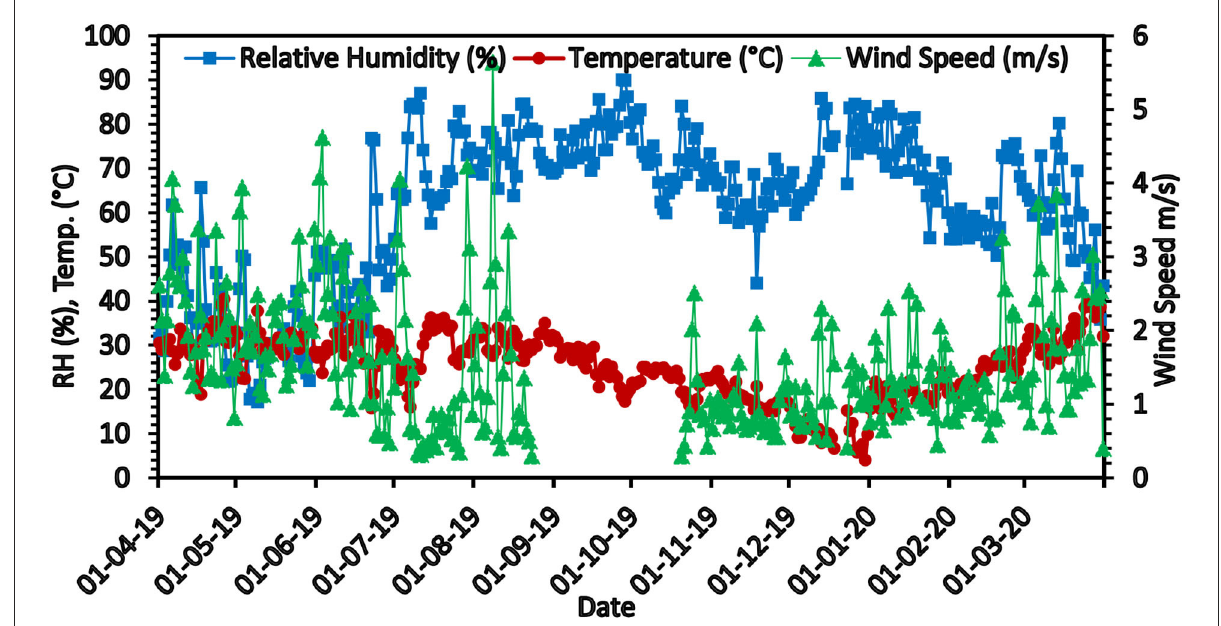
FIGURE1 Meteorological parameters (temperature, relative humidity, and wind speed) during the study